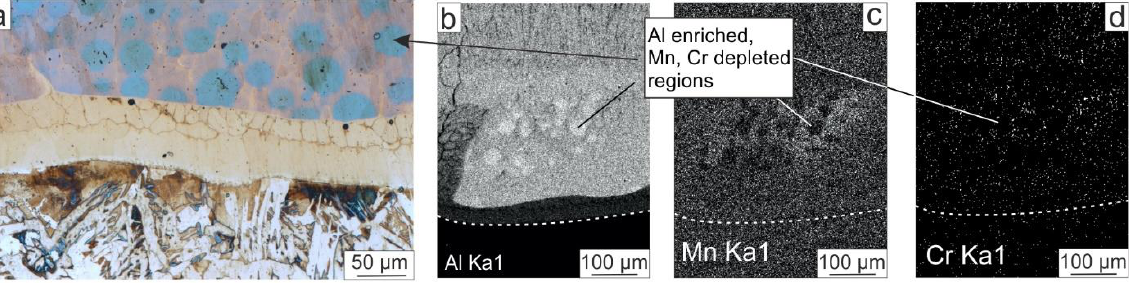
Figure 7. ( a ) Optical microscopy of the “ coating – substrate ” interface; ( b – d ) EDX maps of the spotted zones.